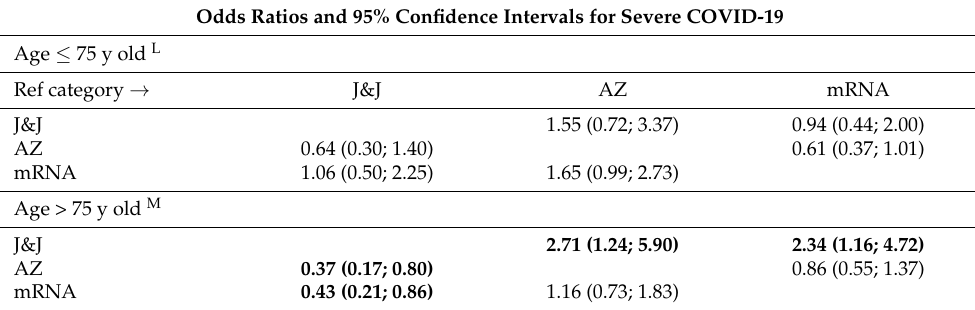
Table A4. Secondary results stratified on age for the outcome severe COVID-19. Odds Ratios and 95% Confidence Intervals for Severe COVID-19